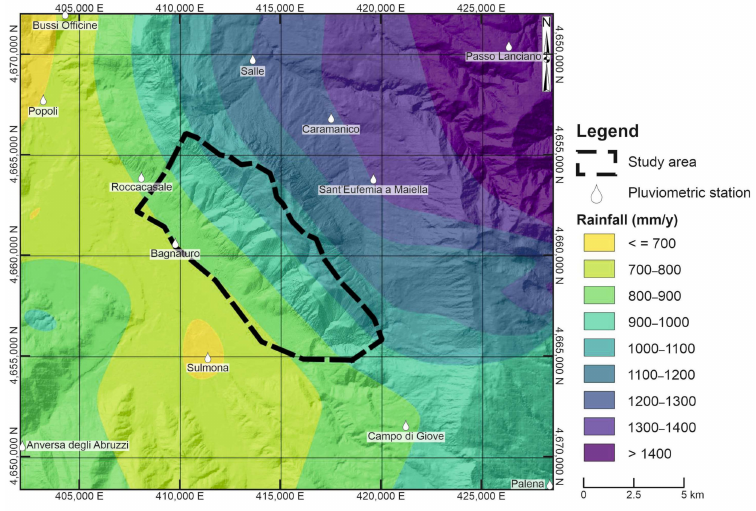
Figure 10. Average annual rainfall map. White dots represent the pluviometric